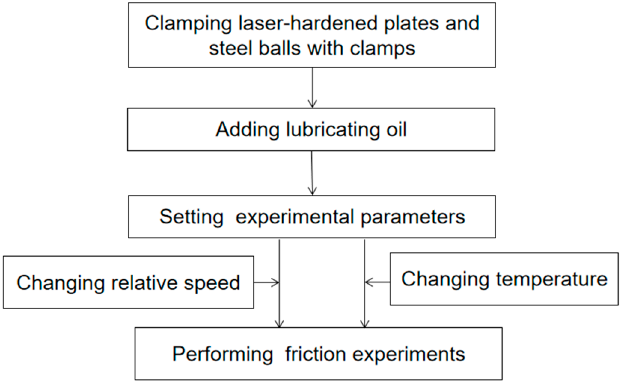
Figure 1. Workflow systematic figure.